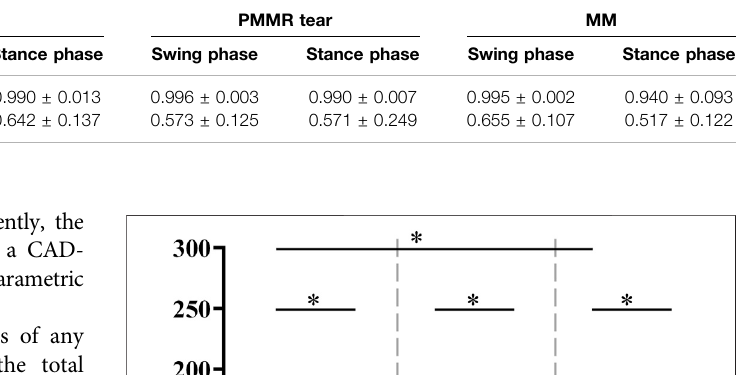
TABLE 1 | Goodness of fi t of the viscous (Crisco et al., 2007) and boundary (Stanton, 1923) friction model to the recorded fl exion-extension data under swing and stance phase loading conditions and the meniscus states intact, after simulation of a posterior medial meniscus root tear (PMMR tear) and after medial meniscectomy (MM), represented by R-squared values (n (cid:1) 6, mean ± standard deviation).